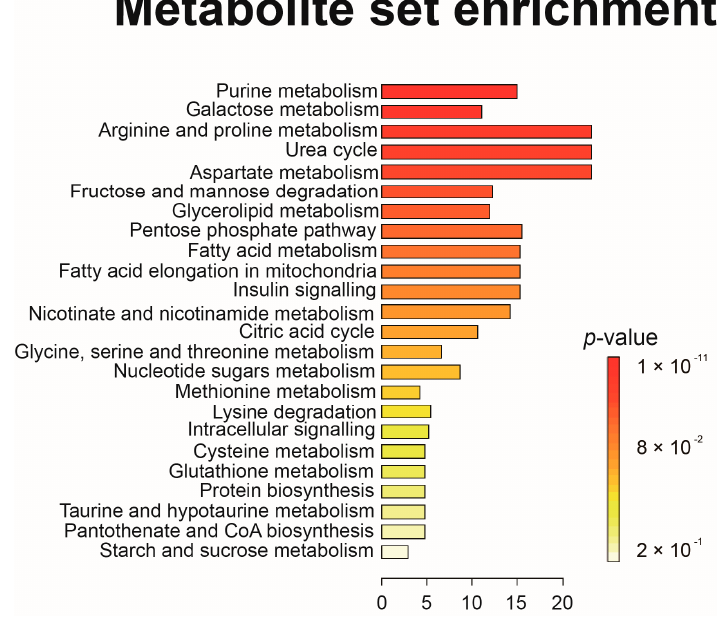
Figure 5. The impact of Behcet’s disease on serum metabolic pathways. To investigate whether metabolism is affected by BD, we performed pathway analysis using MetaboAnalyst. The p value and the pathway impact were calculated from the MSEA and the pathway topology analysis, respectively. The p value threshold was set to 0.01, and the values above this threshold were filtered out as insignificant pathways. The color codes of the bar plot correspond to the calculated p values. The color code of the bar plot corresponds to the calculated p values (red: p = 5 × 10 − 6 to white: p = 1.0).